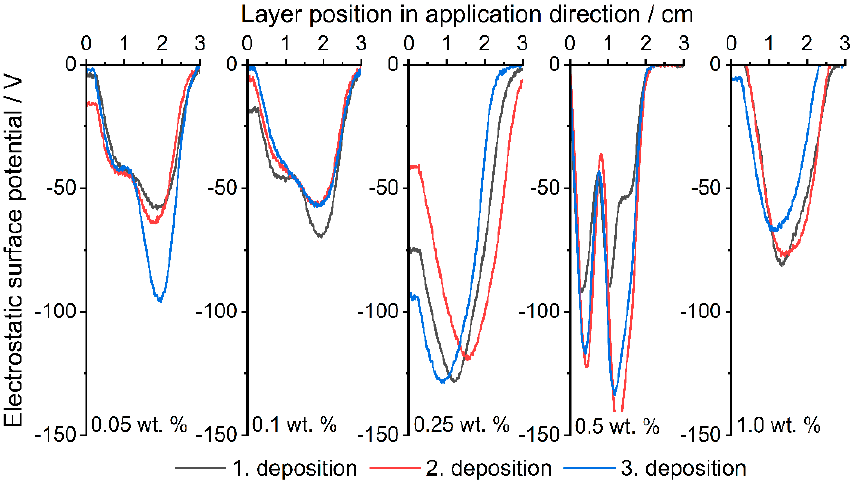
Figure 7. Measured ESP at different layer positions. Comparison between the Silica( − ) formulations; increasing content from left to right.